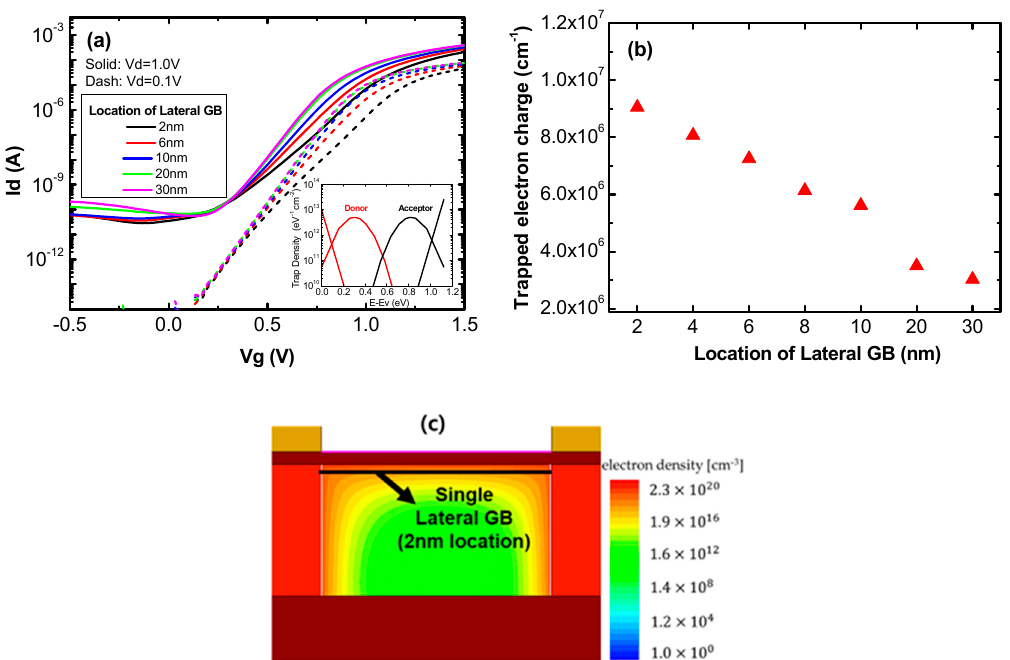
Figure 2. ( a ) Transfer curves of poly ‐ Si 1T ‐ DRAM cells with varied lateral GB locations (inset, the trap densities used in the simulations); ( b ) trapped electron charge according to the location of a single lateral GB; and ( c ) the electron density contour of a device with a lateral GB at 2 nm.